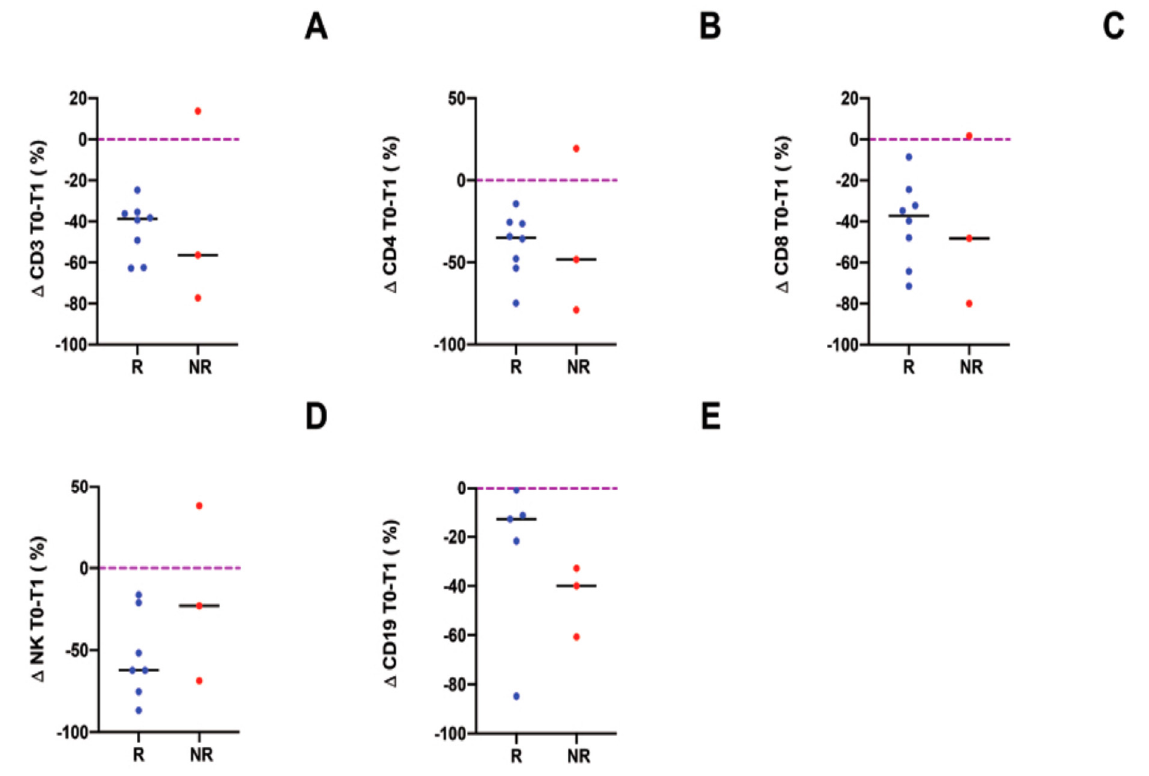
Figure 5. Immune cell subpopulations: CD3 ( A ), CD4 ( B ), CD8 ( C ), NK ( D ), CD19 ( E ) cells were analyzed in all of the patients, except in one R patient and one dropout patient. The data are expressed as ∆ percentage of the cells’ number before (T0) and after 1 year (T1) of ECP treatment.